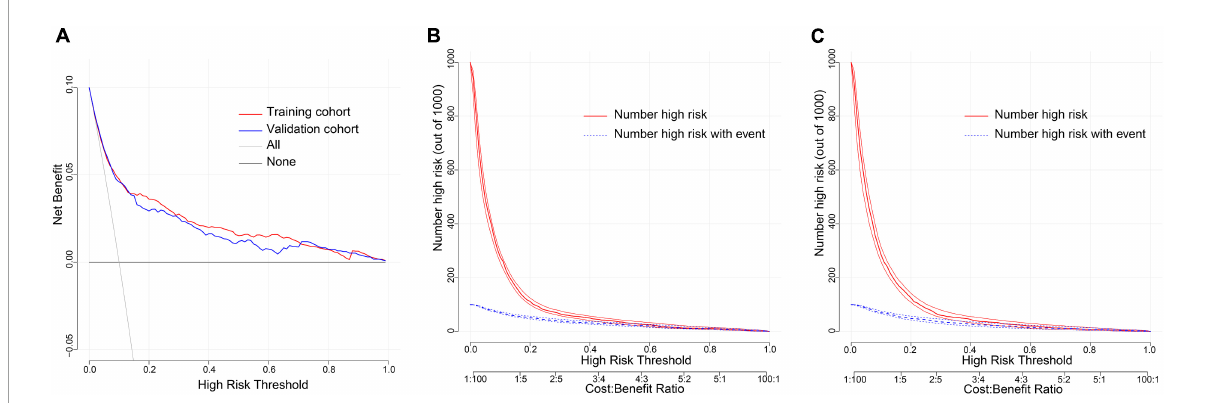
FIGURE6 Evaluation of clinical utility of nomogram prediction models in the training and validation cohorts. (A) Decision curves in both the training and validation cohorts. (B) Clinical impact curve in the training cohort. (C) Clinical impact curve in the validation cohort.